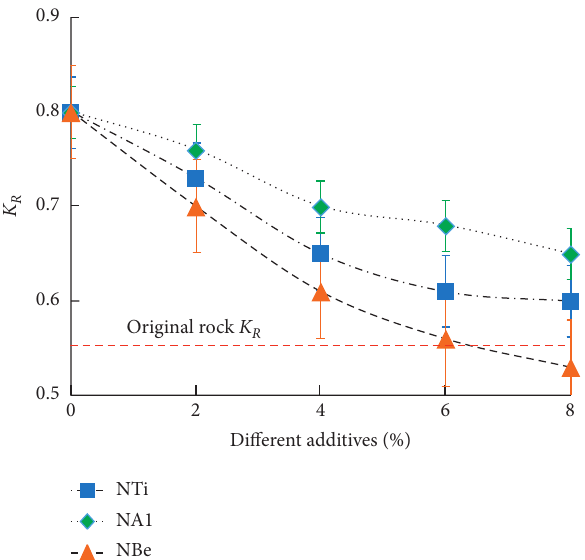
Figure 9: Effect of nanoadditives on softening coefficient of similar